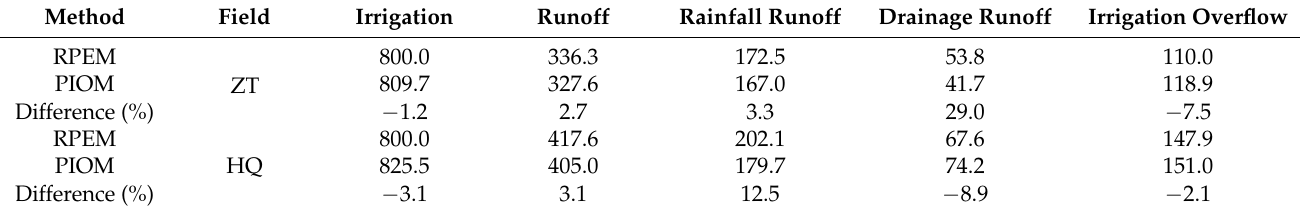
Table 5. Components of the hydrologic budget (mm) using two